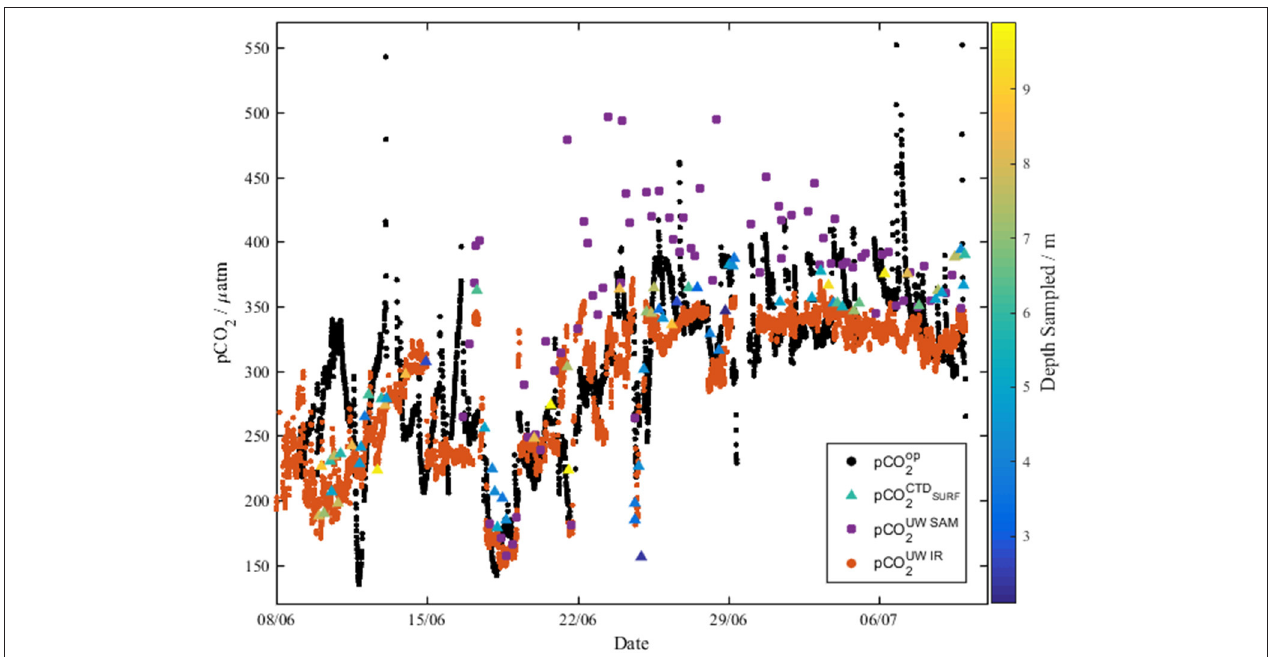
FIGURE 8 | The underway optode pCO 2 (black dots, pCO 2op ) compared to pCO 2 measured with the infrared PML analyzer (orange dots, pCO 2UWIR ), and pCO 2 - calcTA calculated from both underway discrete DIC and TA measurements (purple dots, pCO 2UWSAM ), and CTD discrete DIC and TA measurements (triangles, colored according to the depth sampled, pCO 2CTDSurf